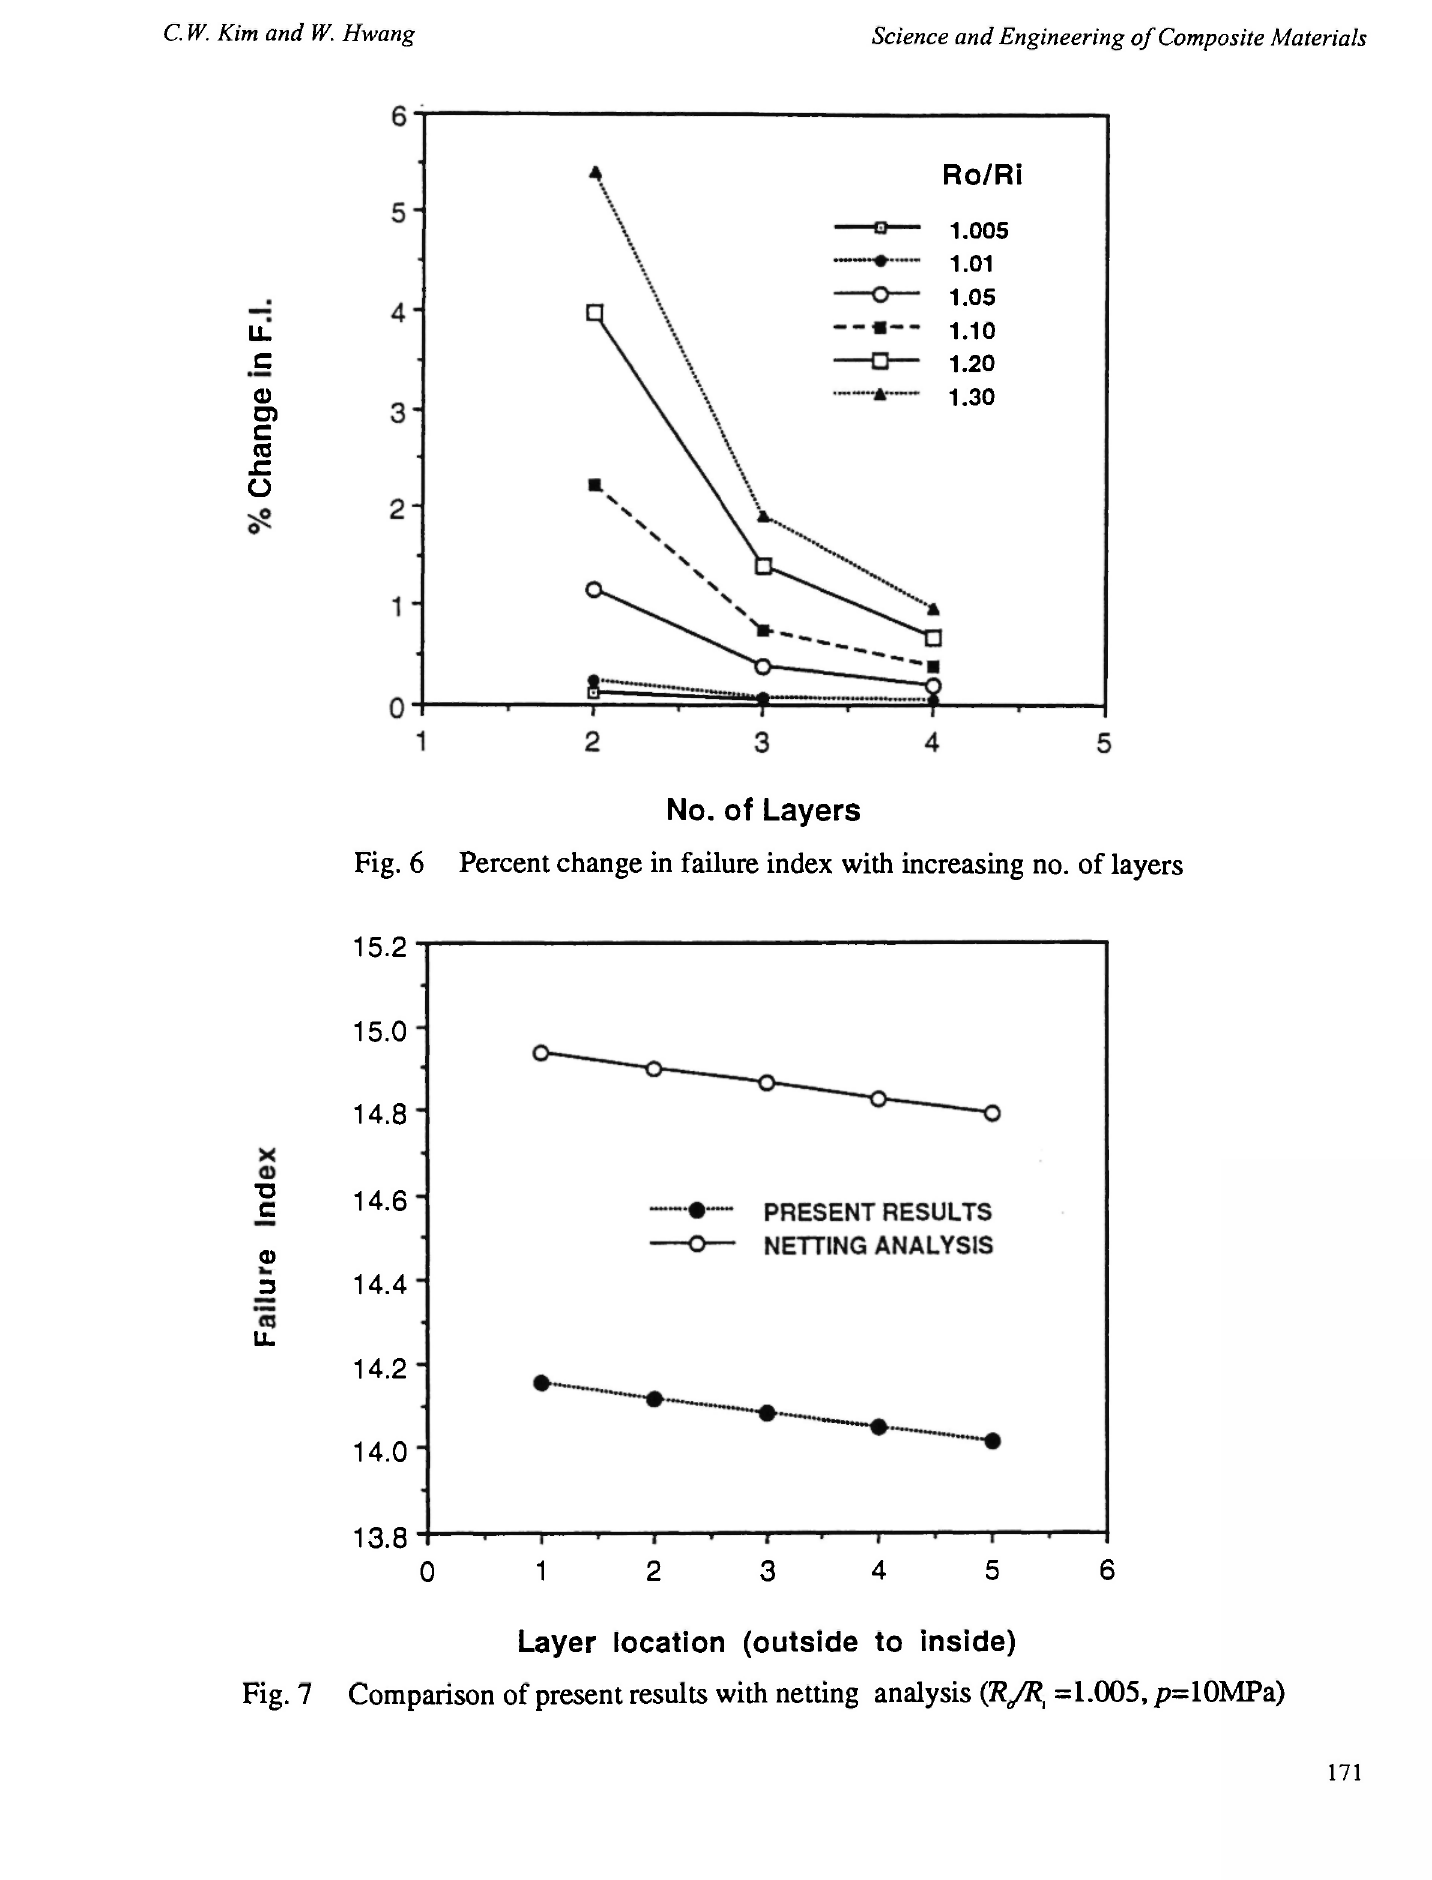
Comparison of present results with netting analysis (R/R,=1.005,